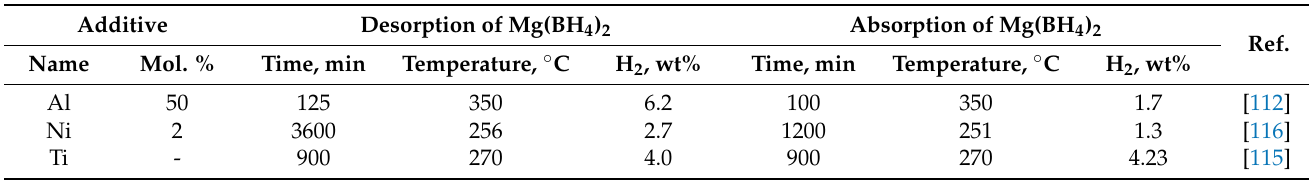
Table 4. Effect of several metals on the desorption and absorption kinetic of Mg(BH 4 ) 2